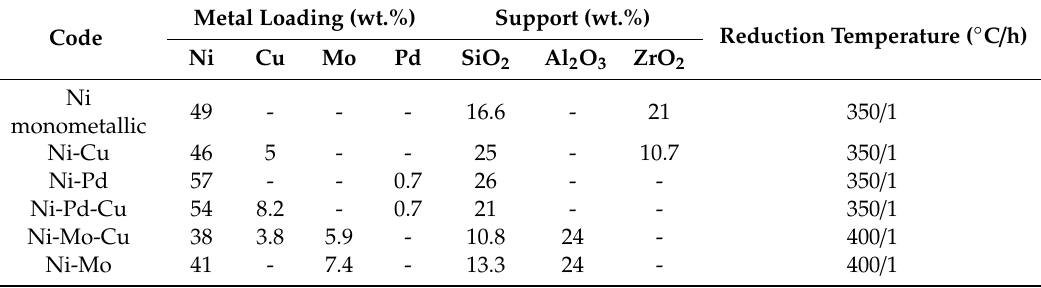
Table 1. Overview of relevant properties of catalysts used in this study a